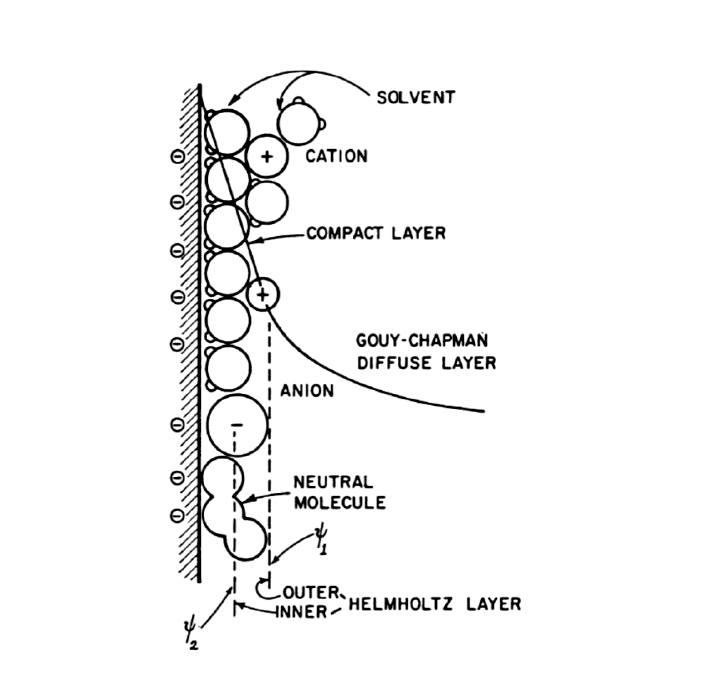
Figure 5. The Grahame model of the double layer, showing different regions for adsorption of smaller, more-hydrated cations and larger, less-hydrated anions. Reprinted with permission from Ref. [3]. 1999,